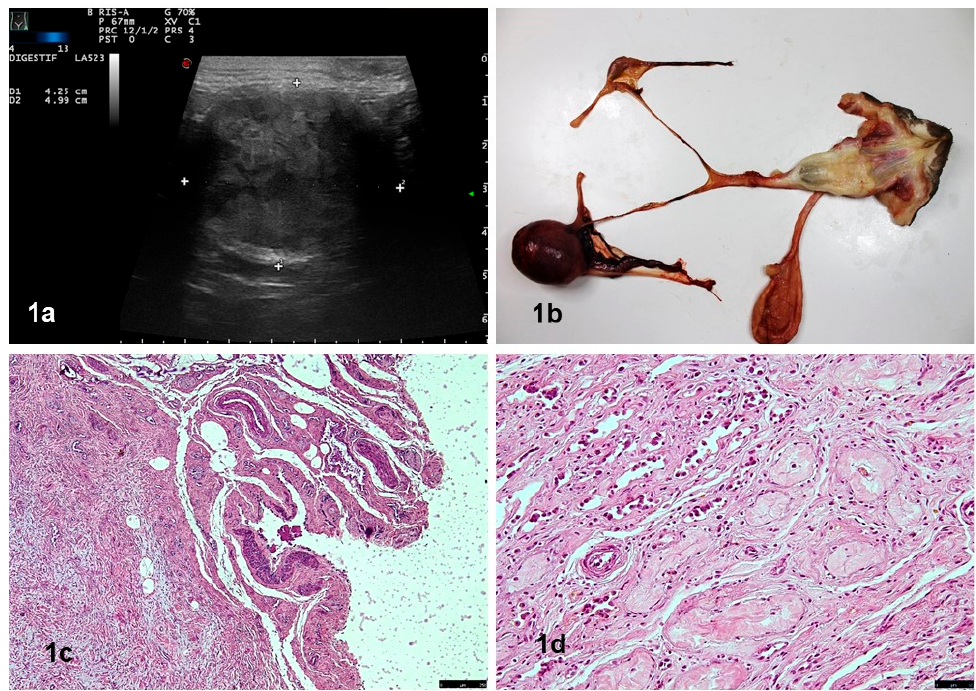
Figure 1. ( a ) Encapsulated mass (5 × 4 cm in size) with a presence of hyperechoic mixed with hypoechoic parenchyma areas. ( b ) Uterus was strongly hypoplastic, with a small body, two slender uterine horns, and a thickened vagina and vulva. ( c ) Uterus: the typical three-layer organization was absent. HE, 5×; ( d ) right gonad: fibro-connective tissue with the occasional presence of coarctated pseudo-seminiferous tubules. HE, 20×.